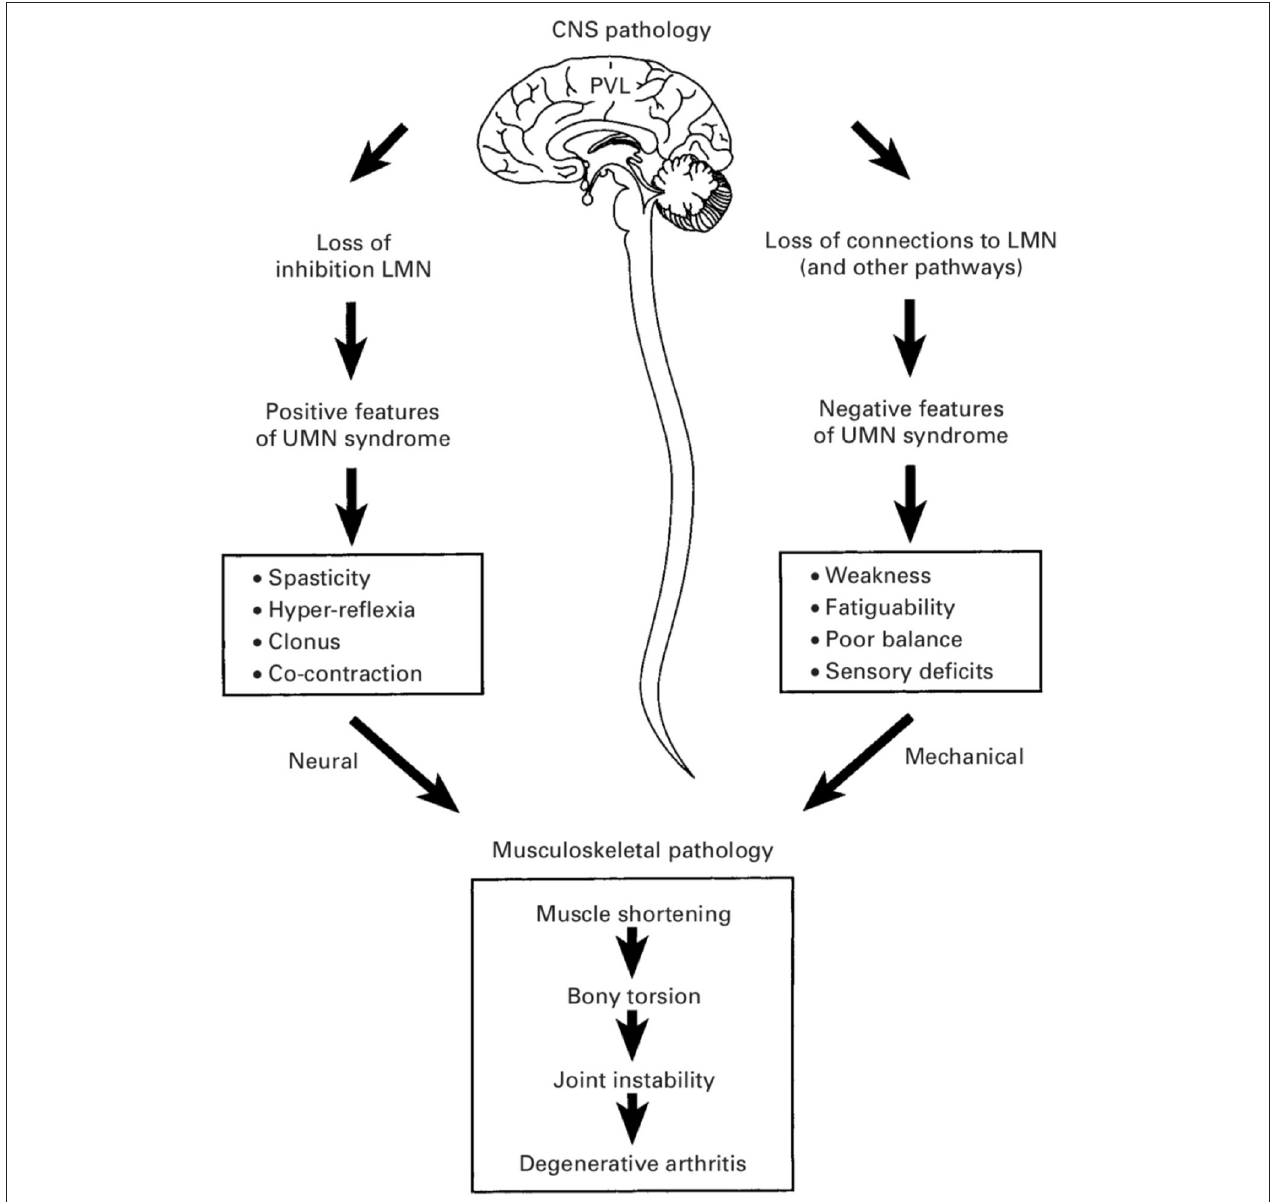
FIGURE 2 | Positive and negative features of the upper motor neuron syndrome in cerebral palsy (CP). The negative features—including weakness, poor balance, and impaired selective motor control—are considered to be more important determinants of gross motor function in CP and are more likely causes of bony deformities and joint instability. (Used with permission © Bill Reid/Kerr Graham, RCH Melbourne).